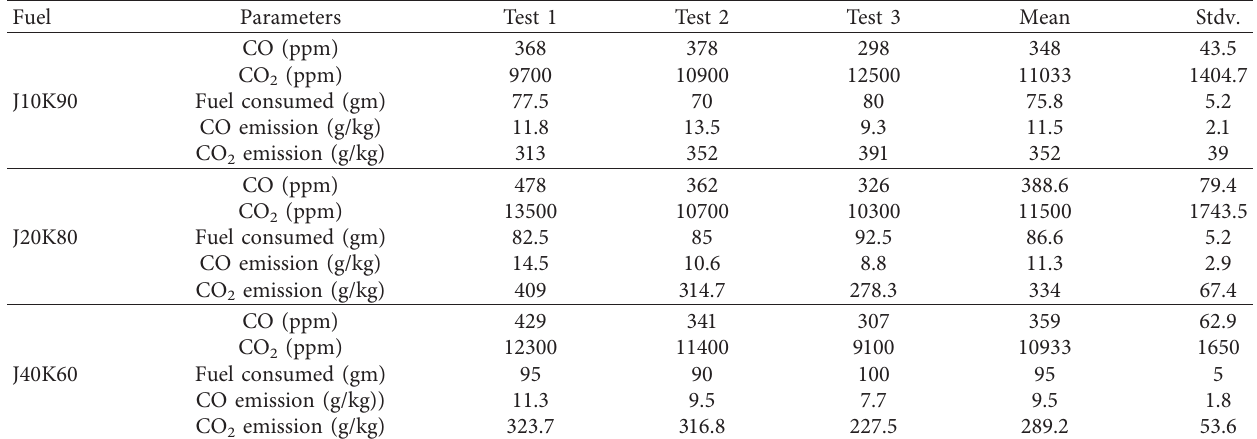
Table 9: Emission test result of the Jatrok stove using blended